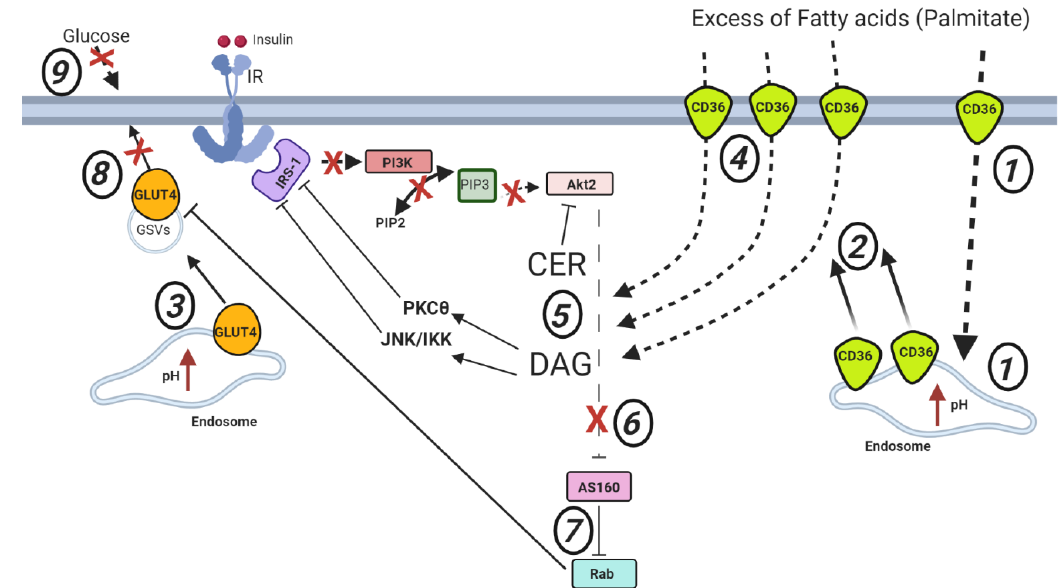
Figure 2. Putative model for the development of (cardiac) lipid-induced insulin resistance. Increasing concentrations of extracellular fatty acids (mostly palmitate) stimulate the uptake of lipids into myocytes via CD36, resulting in an increase in endosomal pH (1). This loss of endosomal acidification ( red arrow ) causes loss of endosomal CD36 retention, thus allowing an abnormal amount of CD36 molecules to relocate to the sarcolemma (2). Loss of endosomal acidification also impacts GLUT4, which is kicked out from the endosome to relocate to GSVs (3). The increased presence of CD36 at the plasma membrane (4) causes an increase in fatty acid uptake and subsequent accumulation of lipid species such as diacylglycerol (DAG) and ceramide (CER). DAG is known to inhibit IRS-1 via activation of JNK/IKK and PKCθ, finally hindering the insulin signaling pathway. CER acts on Akt2